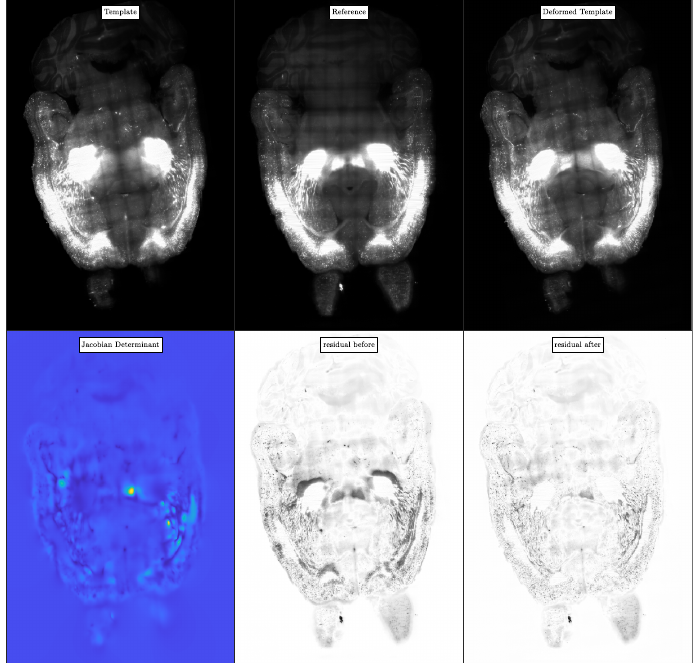
Figure 8. Experiment 3: Illustration of the registration performance for CLAIRE for the CLARITY mouse brain imaging data. We report registration results for the Cocaine178 dataset registered to the Control182 dataset. In row 1 (from left to right), we have the template image m 0 ( Cocaine178 ), the reference image m 1 ( Control182 ) and the deformed template image. The resolution of the images is n = ( 2816,3015,1162 ) . In row 2, we show the determinant of the deformation gradient and the image residuals before and after